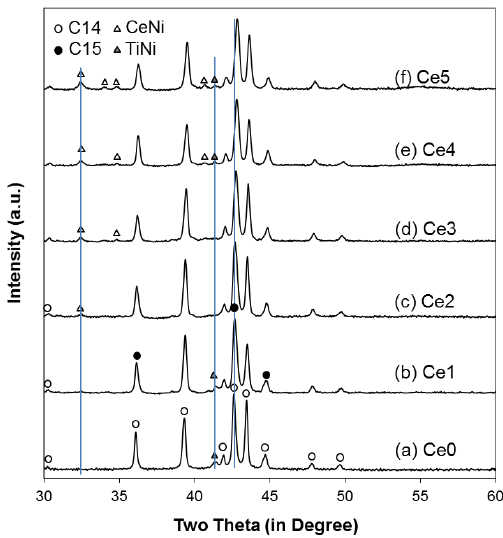
Figure 2. X-ray diffraction (XRD) patterns from alloys: ( a ) Ce0; ( b ) Ce1; ( c ) Ce2; ( d ) Ce3; ( e ) Ce4; and ( f ) Ce5. Vertical lines show the shift exists for the C14 peak but not for the CeNi or TiNi phases. Table 3. Lattice constants a and c , a / c ratio, unit cell volume ( V C14 ), full-width at half-maximum (FWHM) for the (103) peak, and crystallite size for the C14 phase, lattice constant a for the C15 phase, and phase abundances in wt% calculated from the XRD analysis.